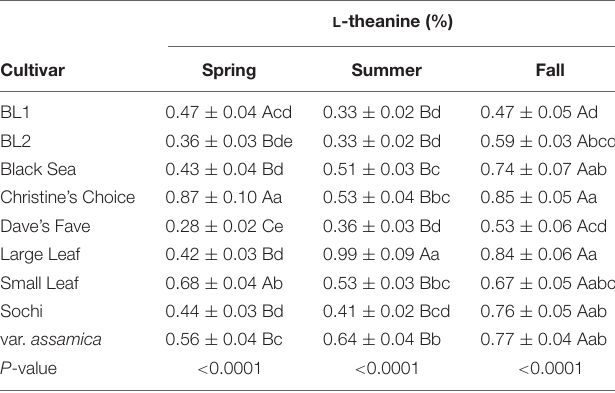
TABLE 5 | Content of L -theanine in tea extract in three harvest seasons and nine cultivars grown in Mississippi, United States. L -theanine